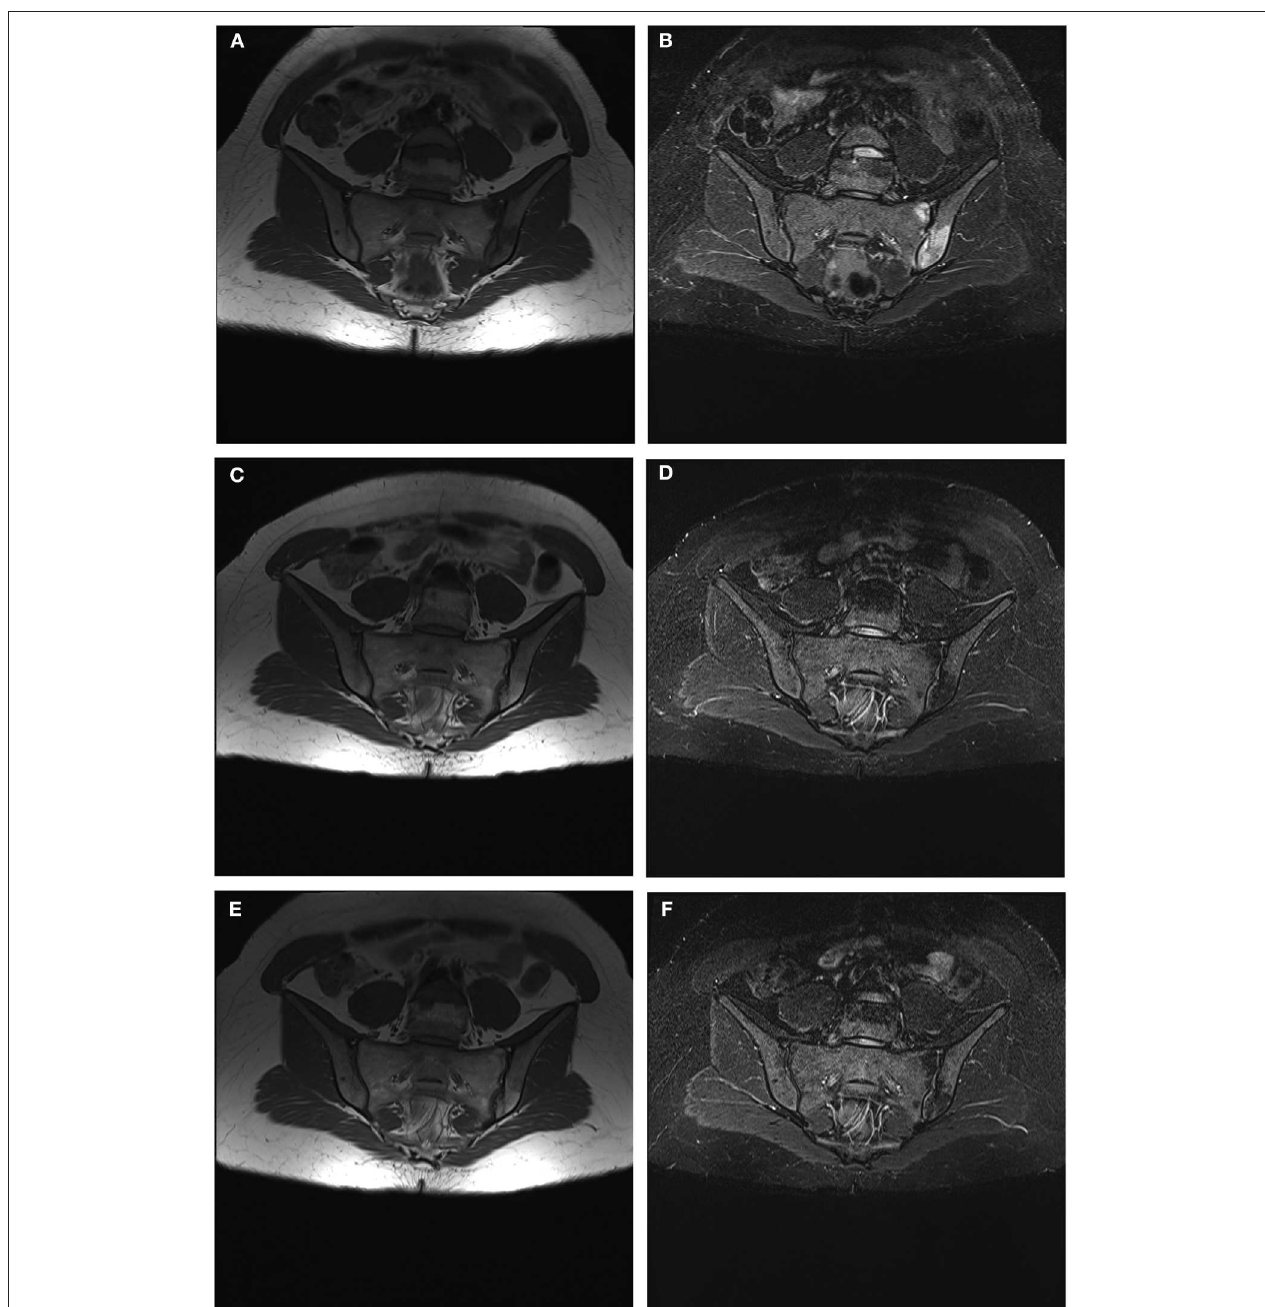
FIGURE 4 | (A–F) Progressive reduction until disappearance of BMO signs and subsequent corresponding appearance of signs of adipose metaplasia on left SIJ during a follow up period of 24 months. (A) MRI-SIJ at T0 in T1 sequence (B) MRI-SIJ at T0 in STIR sequence (C) MRI-SIJ at T12 in T1 sequence (D) MRI-SIJ at T12 in STIR sequence (E) MRI-SIJ at T24 in T1 sequence (F) MRI-SIJ at T24 in STIR sequence. The written informed consent was obtained from the individual for the publication of these images.